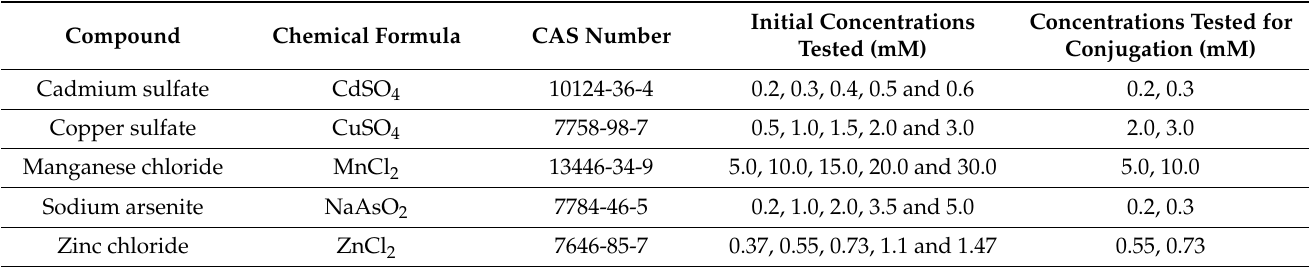
Table 1. Chemicals tested in this